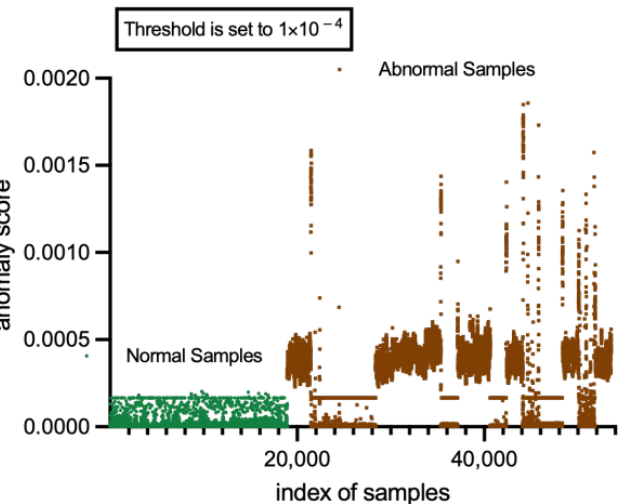
Figure 13. Anomaly scores of normal samples and abnormal samples produced by CL-MMAD using MSE loss.